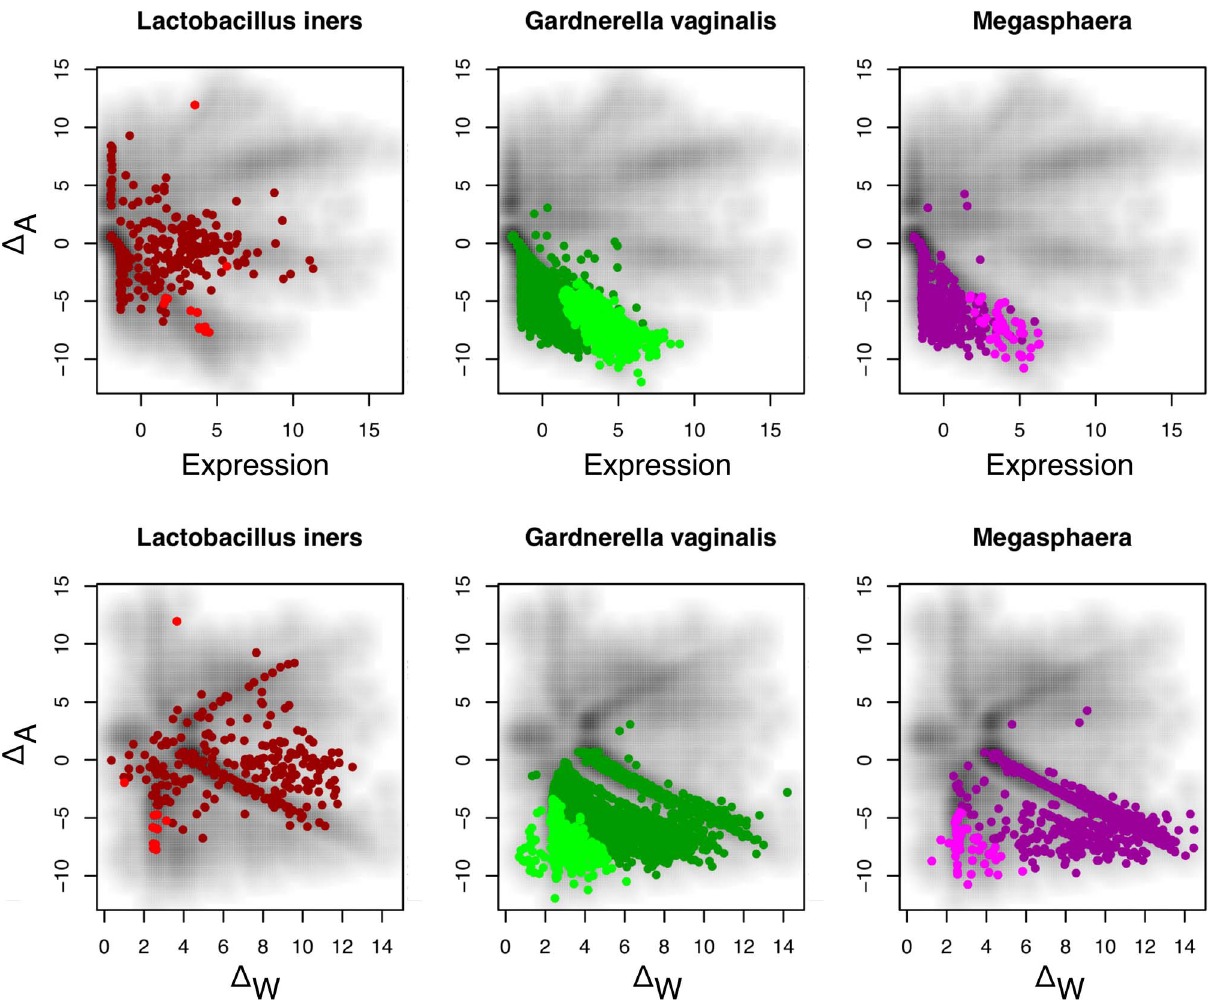
Figure 9. The effect of organism abundance on transcript abundance in the Meta dataset. In each panel, the dark colour indicates a gene that maps to that organism (or organism group) and the bright colour indicates a gene that is differentially expressed according to the rules enforced by ALDEx. The Meta dataset contains different mixtures of organisms in each sample as shown in Table 2. This leads to widely different distributions of transcript abundance in this dataset, which can be classified into three general patterns. Transcripts from organisms that are abundant ( § 1 % ) in three or four samples can exhibit both up and down regulation in the two conditions. For example, transcripts that were derived from L. iners are seen to be both up- and down-regulated in this dataset. Transcripts from organisms that are abundant in both samples of one condition (e.g. G. vaginalis ), exhibit a change in one direction only, and show the full range of within-condition variation. In this case, many genes from the organism are expressed concordantly, and can be identified as differential. Transcripts from organisms that are abundant in only one sample of one condition, e.g. Megasphaera species, show a similar pattern as the previous one, but there is much more extreme variation within-conditions, and only those few genes that are expressed at extremely high levels can be reliably called as differentially